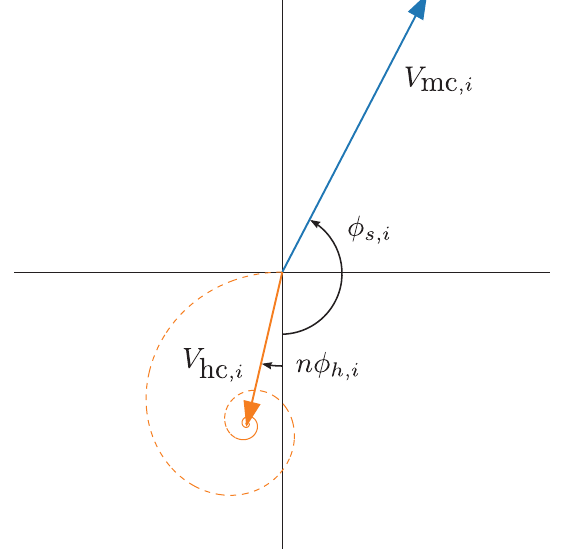
FIG. 2. Phasors for main and harmonic cavity voltages. The dashed line indicates the build up of the beam loading in a passive harmonic cavity and that a steady-state solution will eventually be reached after many passes through the cavity. The sign of the angles are indicated by arrows where counterclockwise corre- sponds to positive